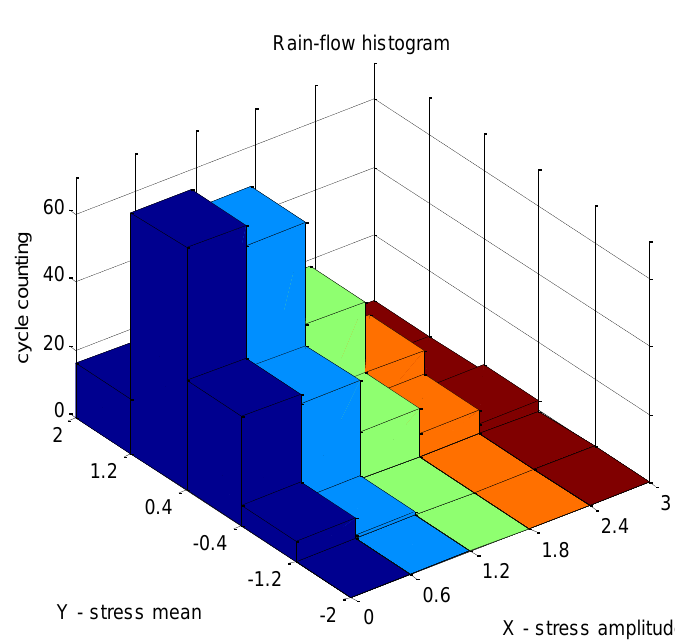
Figure 6. Rain-flow